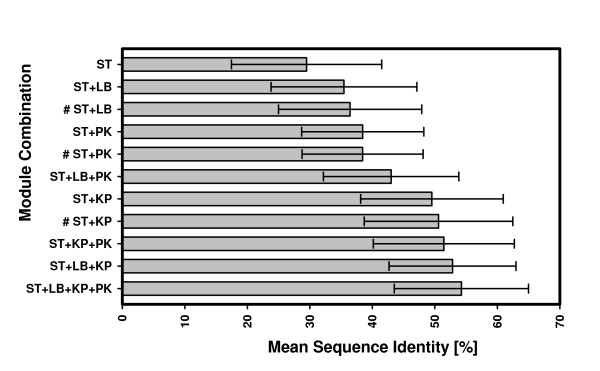
The performance of different module combinations of TransCent as judged by in silico recapitulation of active sites. Mean IDENT_RES values and standard deviations were determined for different combinations of modules. Abbreviations for modules are: ST (stability), LB (ligand binding), KP (knowledge-based potential), and PK (pKa values). For each combination of modules, 20 models were generated for each enzyme belonging to ENZ_TESThom. Values labeled with a # originate from a leave-one-out cross validation test.